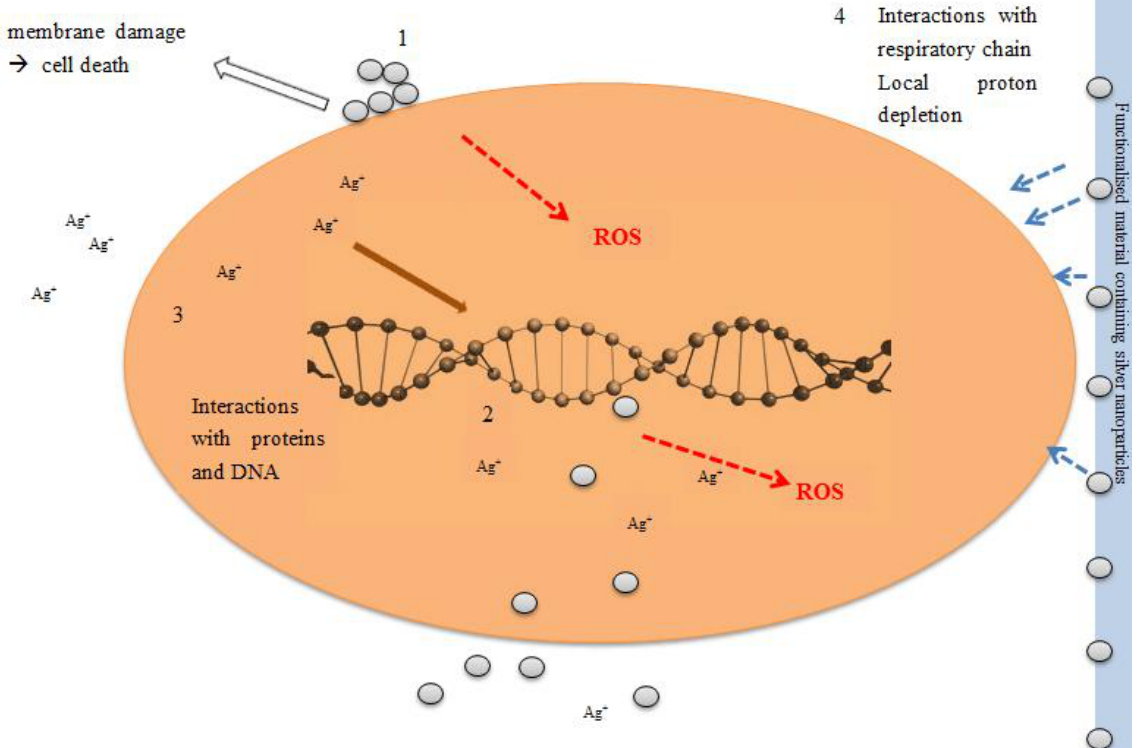
Figure 3. Schematic representation of the known mechanism(s) of antibacterial action of silver nanoparticles and released ionic silver. The numbers 1–4 correspond to the mechanisms described in the paragraphs above. Grey circles indicate silver NPs and Ag + implies ionic silver released from the